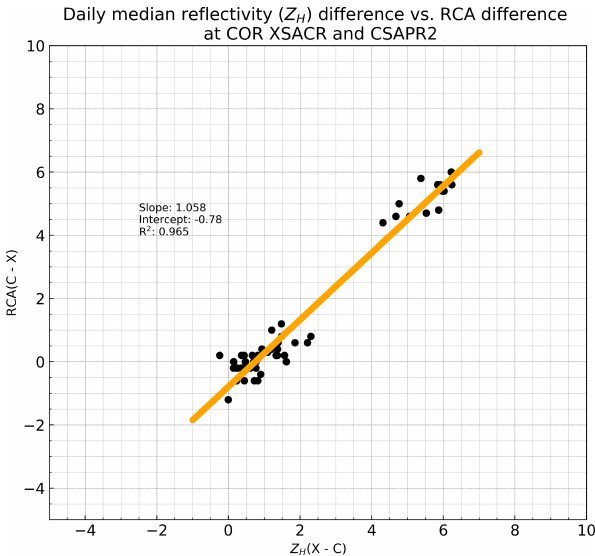
Figure 15. The scatter plot of the difference of RCA values between CSAPR2 and XSACR compared to the difference in mean filtered reflectivities between the two radars. This shows that RCA captures the change in reflectivity calibrations as well as the direct compari-